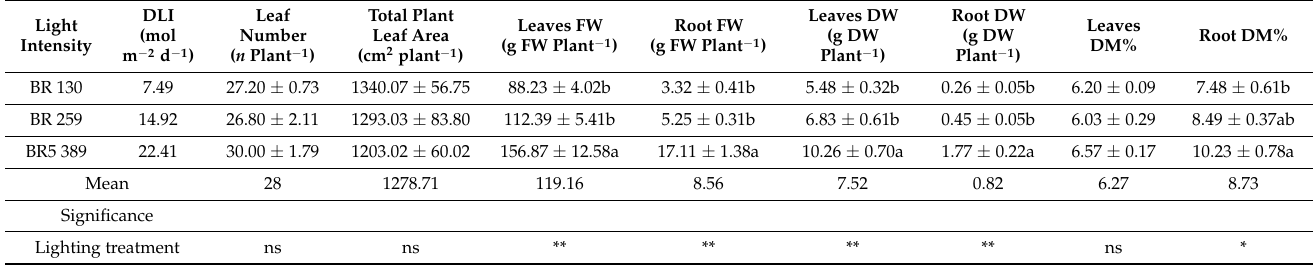
Table 3. Plant growth in terms of leaf number, total plant leaf area, fresh leaves weight (leaves FW), fresh root weight (root FW), dry leaves weight (leaves DW), dry root weight (root DW), dry leaves biomass content (leaves DM), dry root biomass content (root DM) in lettuce type Batavia cv ‘Blackhawk’ grown under three different light intensities (130, 259, 389 µ mol m − 2 s − 1 ). Mean values ± standard errors ( n = 5, 33 DAT). Different letters indicate significant differences at p < 0.5 according to Tukey’s HSD post hoc test. Non-significant or significant differences at p < 0.5 and 0.01 are reported as ns, *, and **